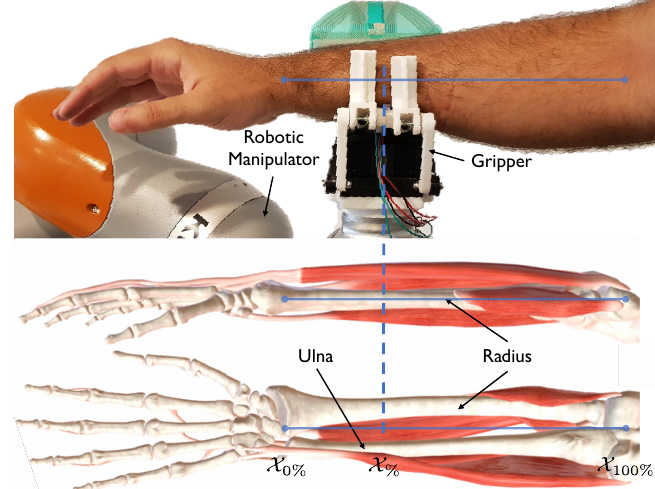
Figure 1. The robotic manipulator with the three-fingered gripper performs a grasp to recognize the location of the grasped forearm. Bones and muscles present different shapes and sizes along the forearm. The 3D images of the musculoskeletal model at the bottom are from BioDigital